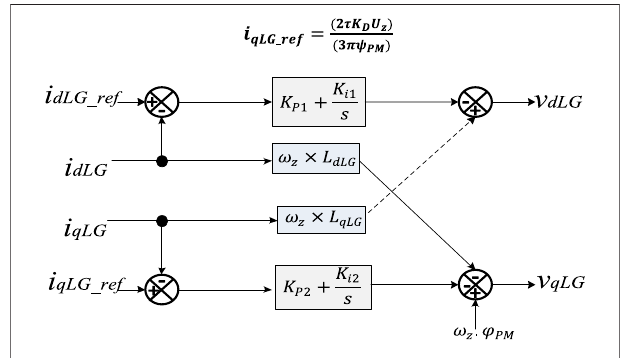
FIGURE 5 | Representation of controller framework used for the design of